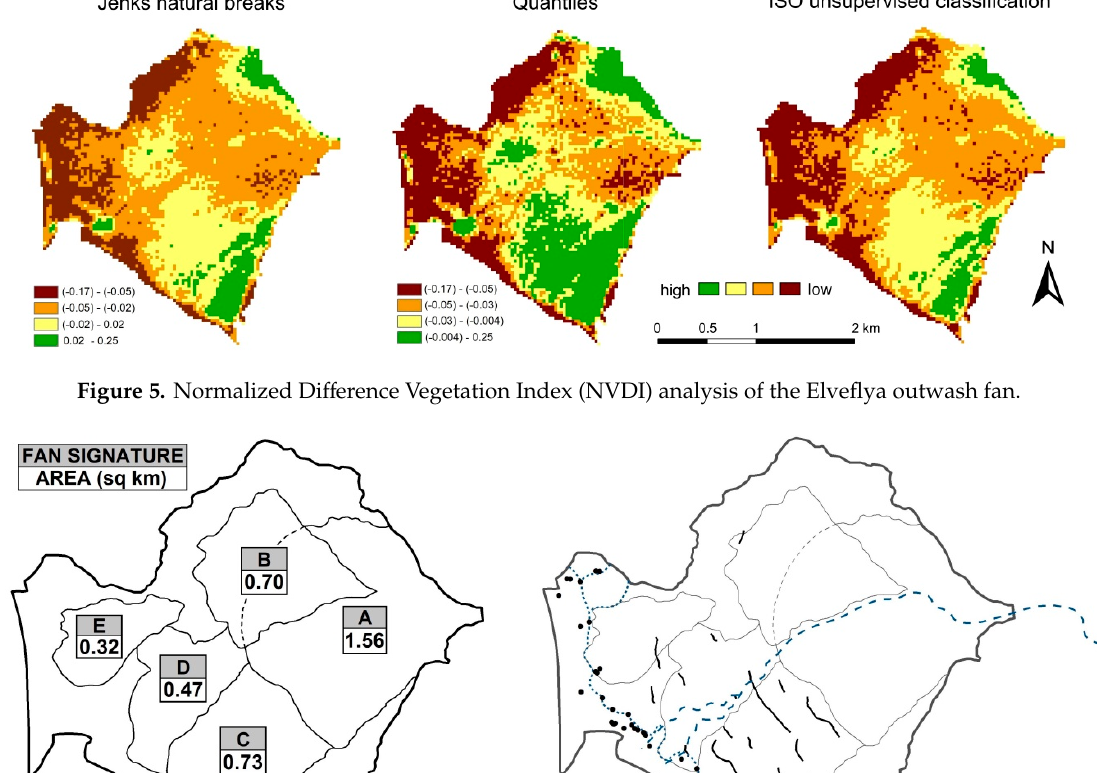
Figure 4. Results of the Elveflya outwash fan photointerpretation.